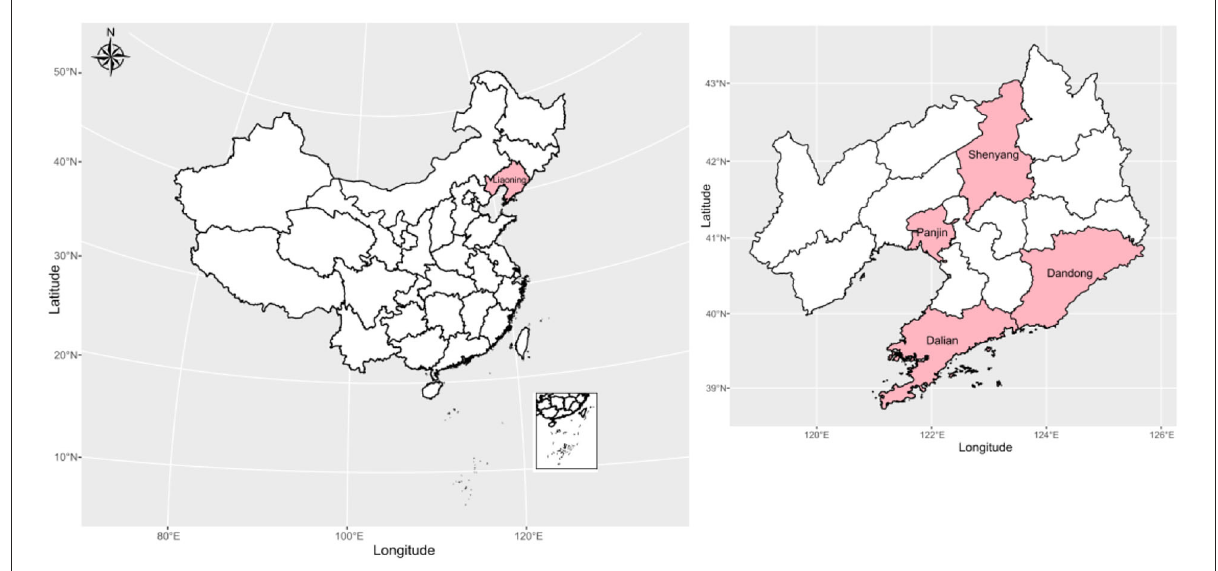
FIGURE1 Geographical positions of the sampling population in this